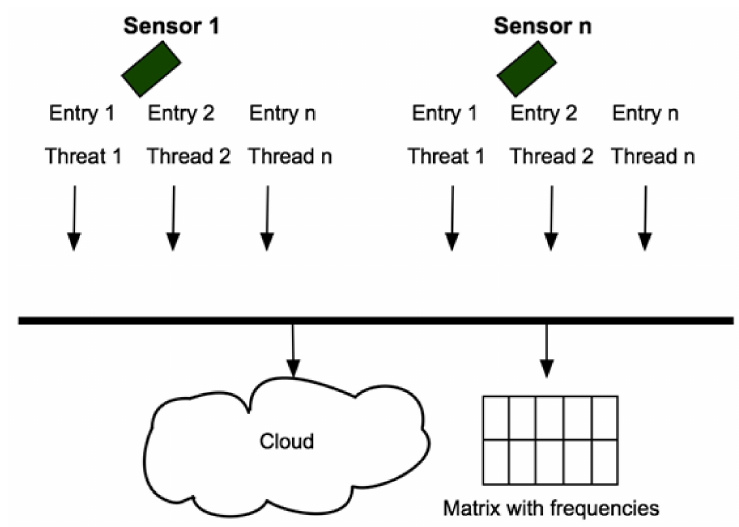
Figure 5. A general scheme of big data analysis with classification threads, an updated matrix with frequencies of pollution levels, and cloud